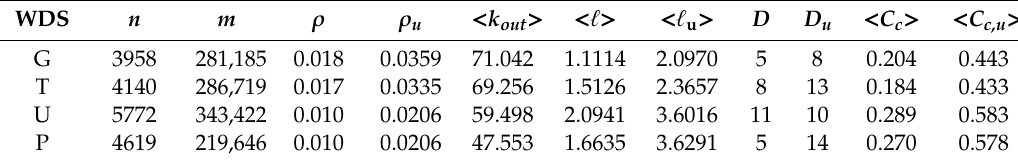
Table 2. Main properties of the virtual networks built from extended period simulations and source tracing analyses ( n , number of nodes; m , number of links). Symbols with the subscript u refer to the undirected network. ρ , network density; < k out > , average out-node degree; < (cid:96) > , average path length; D , network diameter; < C c > , average clustering coe ffi cient.